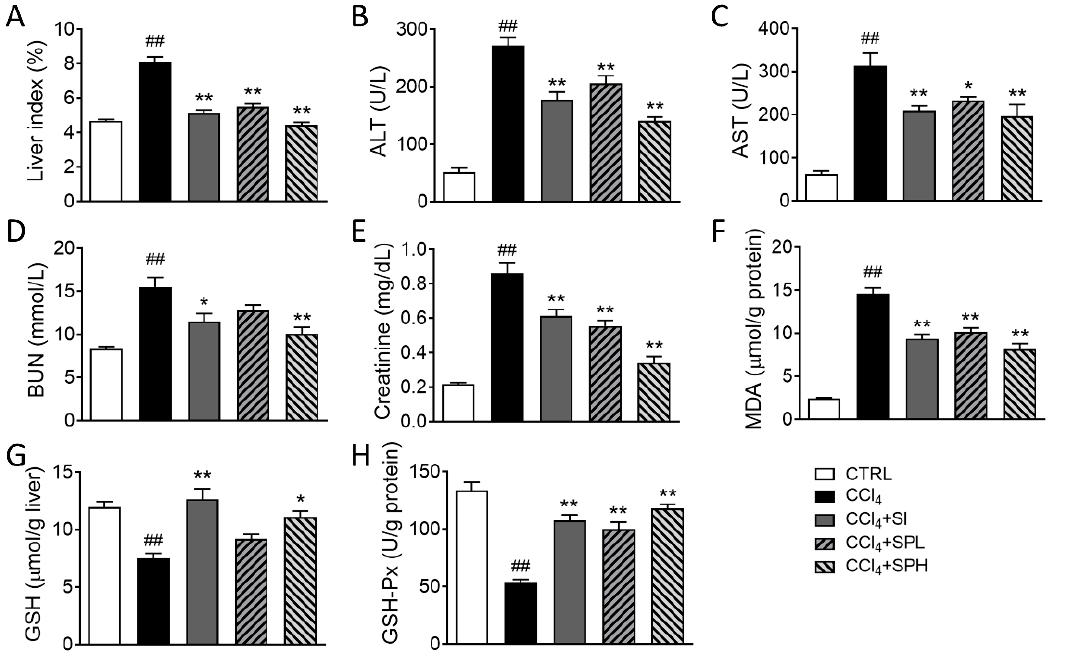
Figure 2. Effect of spore powder of A. camphorata on the serum and tissue biomarkers in CCl 4 -treated mice. ( A ) Liver index. ( B ) Serum ALT level. ( C ) Serum AST level. ( D ) Serum BUN level. ( E ) Serum creatinine level. ( F ) MDA level of liver tissues. ( G ) GSH level of liver tissues. ( H ) GSH-Px level of liver tissues. Data are presented as mean ± SEM (n = 6). Different letters indicate significantly different values according to a one-way ANOVA using Tukey’s test for multiple comparisons. Compared with control group (CTRL), ## p < 0.01; compared with CCl 4 induced group (CCl 4 ), * p < 0.05, ** p < 0.01. CCl 4 , carbon tetrachloride; ALT, alanine aminotransferase; AST, aspartate aminotransferase; BUN, blood urea nitrogen; MDA, malondialdehyde; GSH, glutathione; GSH-Px, glutathione